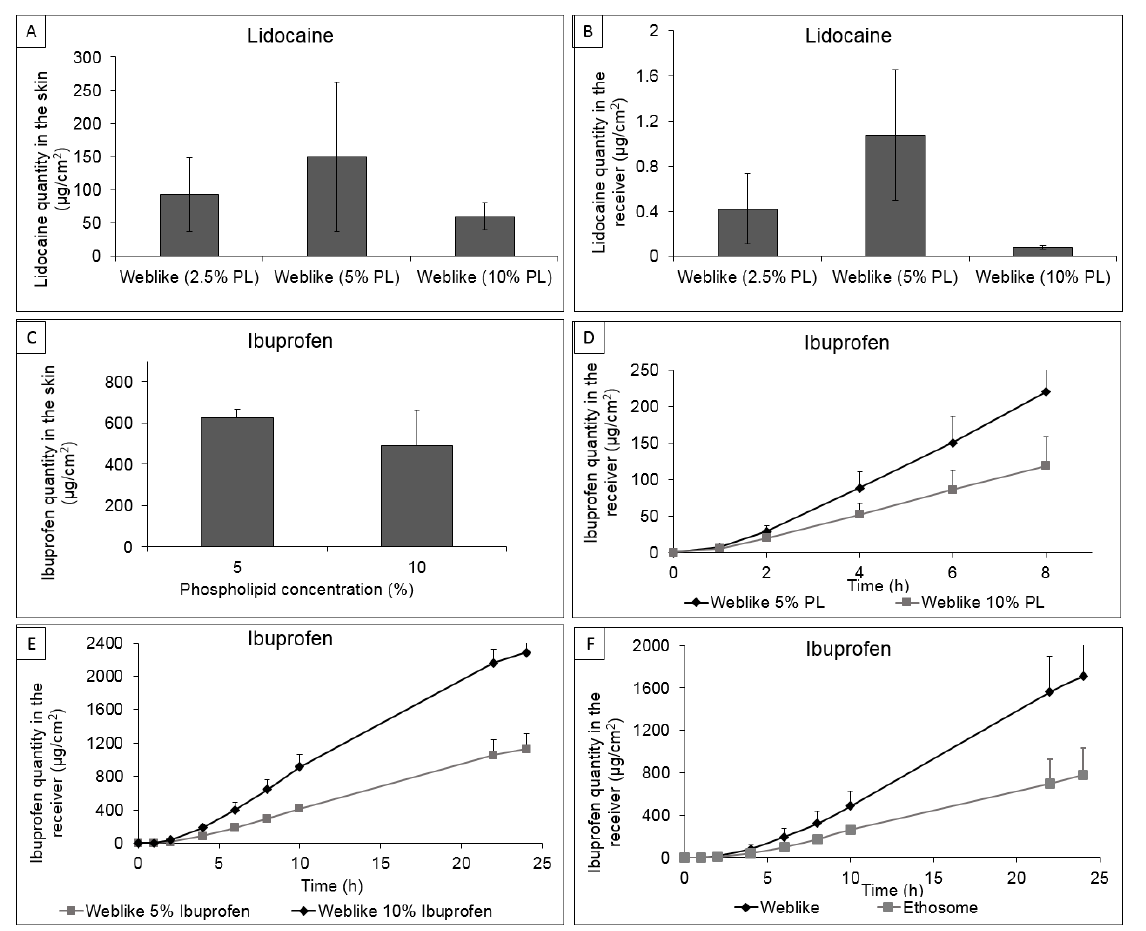
Figure 3. In vitro delivery into or across the skin of Lidocaine or Ibuprofen non-occlusive application of Weblike systems: ( A ) Lidocaine penetration into the skin 30 min following application in Weblike systems containing various phospholipid concentrations (F10 – F12); ( B ) Lidocaine permeation across the skin 30 min following application in Weblike systems containing various phospholipid concentrations (F10 – F12); ( C ) Ibuprofen penetration into the skin during 8 h following Weblike systems containing various concentrations of phospholipid (F14, F15); ( D ) Ibuprofen permeation across the skin during 8 h following application of Weblike systems containing various phospholipid concentrations (F14–F15); ( E ) Ibuprofen permeation across the skin during 24 h following application of Weblike systems containing various Ibuprofen concentrations (F13, F14) ( F ) Ibuprofen permeation across the skin during 24 h following application in Weblike system (F14) and in Ethosome. n = 5, Mean ±